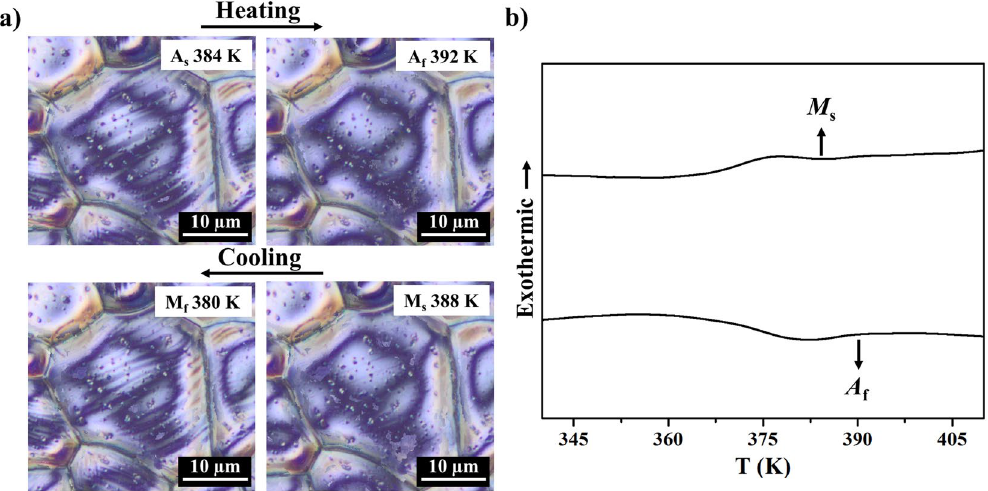
Figure 14. ( a ) Surface micrographs and ( b ) DSC measurement of the alloys Ni 0.500 Mn 0.385 Sn 0.115 during heating and